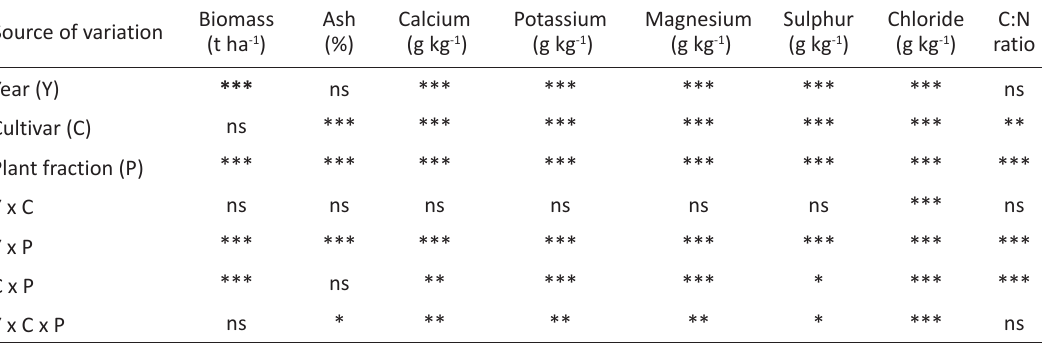
Table 3. Interactions and significance values of biomass yield, ash content and mineral element composition of eight maize cultivars and their plant fractions in 2010 and 2011 Source of variation